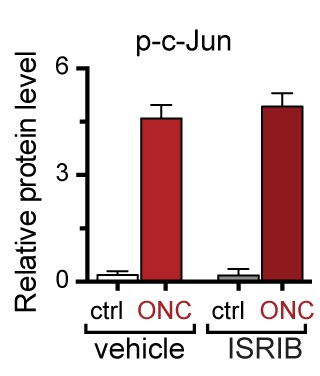
Quantification of p-c-Jun immunoblots presented in Figure 7e (ONC in mice dosed with ISRIB).